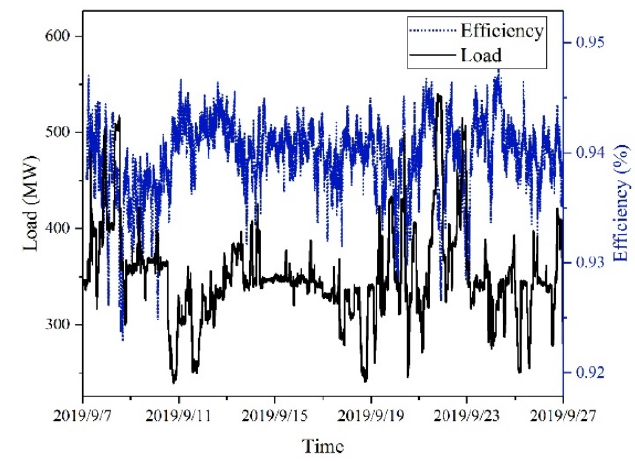
Figure 2. Load and efficiency of the boiler in the final dataset.